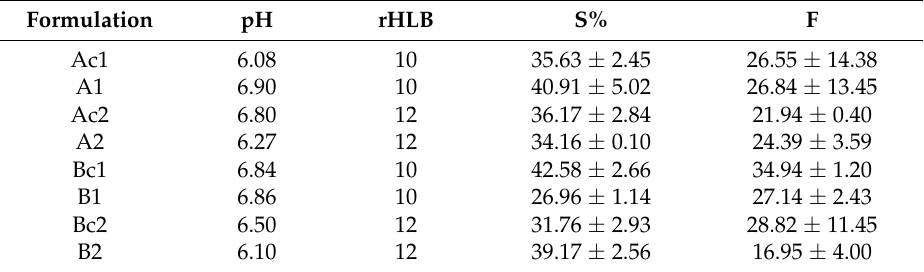
Table 3. Technological parameters, pH, required hydrophilic lipophilic balance (rHLB), spreadability (S%), and occlusion factor (F) of sunscreen oil-based